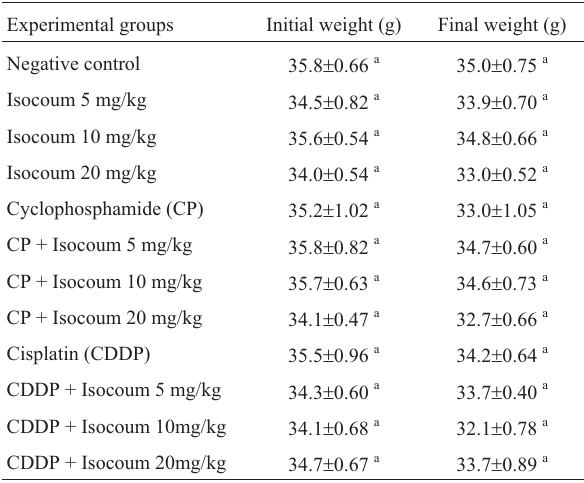
Table 1 - Means (cid:5) SE of the initial and final weights of Swiss mice treated with different doses of isocoumarin. Experimental